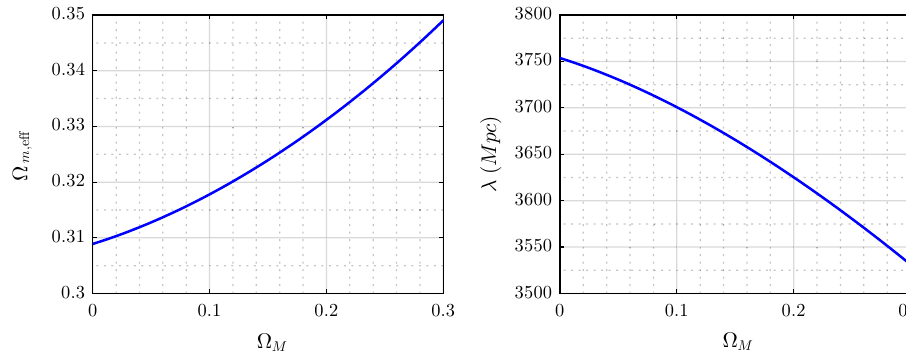
Fig. 1 Plots of the effective mass density and the screening length versus (cid:2) M